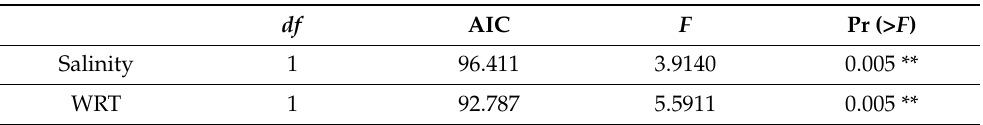
Table 2. Statistically significant explanatory variables for the catch of individual species (ordistep procedure) .